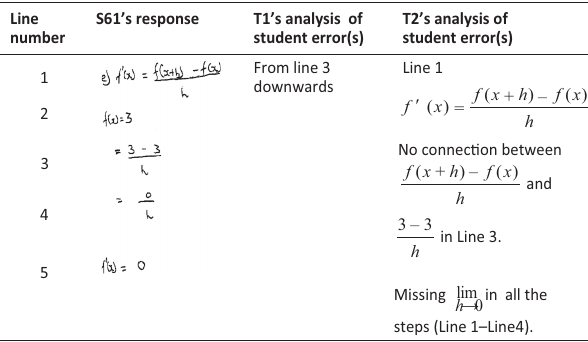
FIGURE 2: Error analysis of S61’s